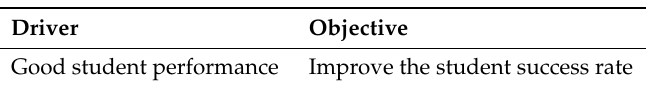
Table 5. Defined driver and